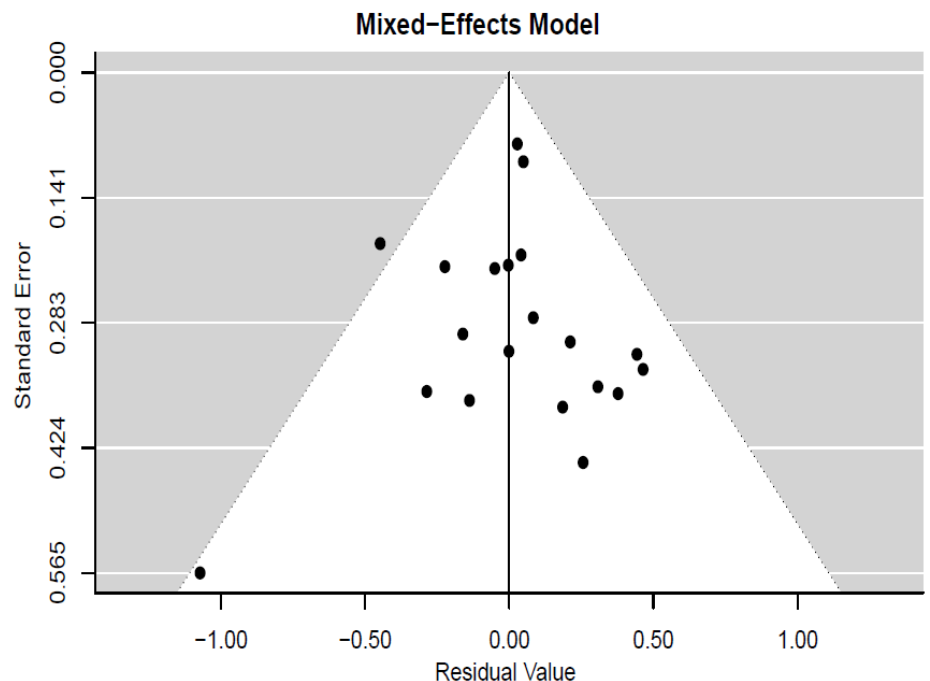
Figure 7. Funnel plot for mixed effects